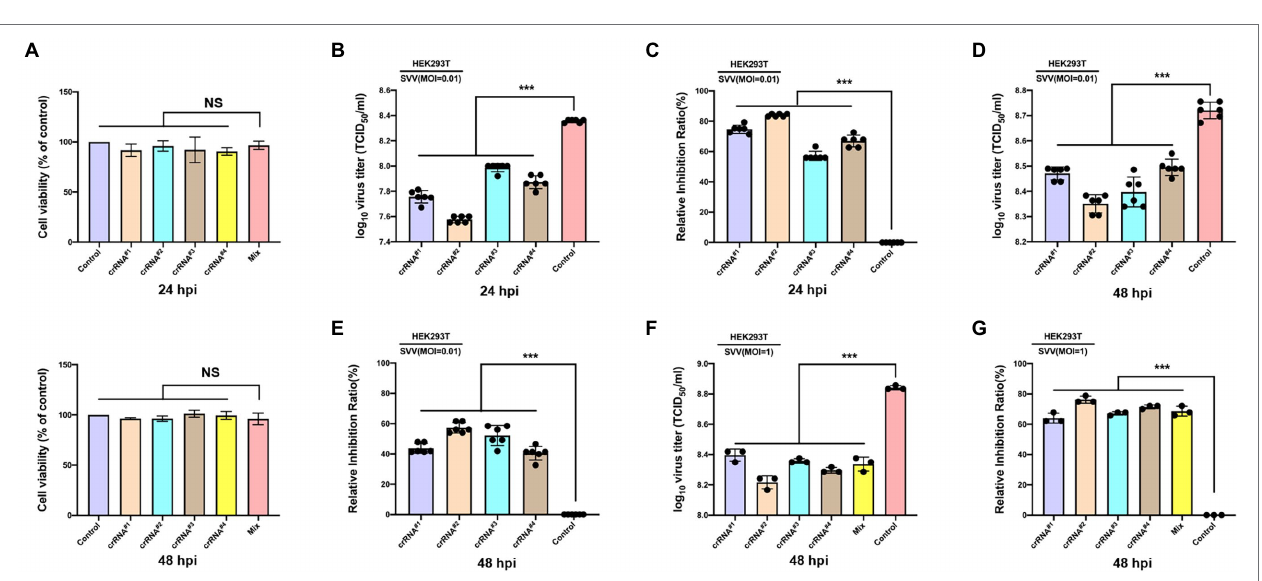
FIGURE 3 | Programmable targeting of SVV RNA by Cas13d. The CasRx-del-NLS plasmid cotransfected with (A) control crRNA plasmid or (B) targeted crRNA#1 plasmid into HEK293T cells. At 24 hpi, the cells were infected with SVV (at an MOI of .3). Thirty-six hours post-infection, SVV VP2 was detected by IFA with an anti- VP2 monoclonal antibody and Alexa Fluor 568-conjugated goat antibodies. CasRx expression was indicated by EGFP, and nuclei were labeled with DAPI. (C) Manders’ colocalization coefficients was analyzed, six random selected images were analyzed by ImageJ. *** p <